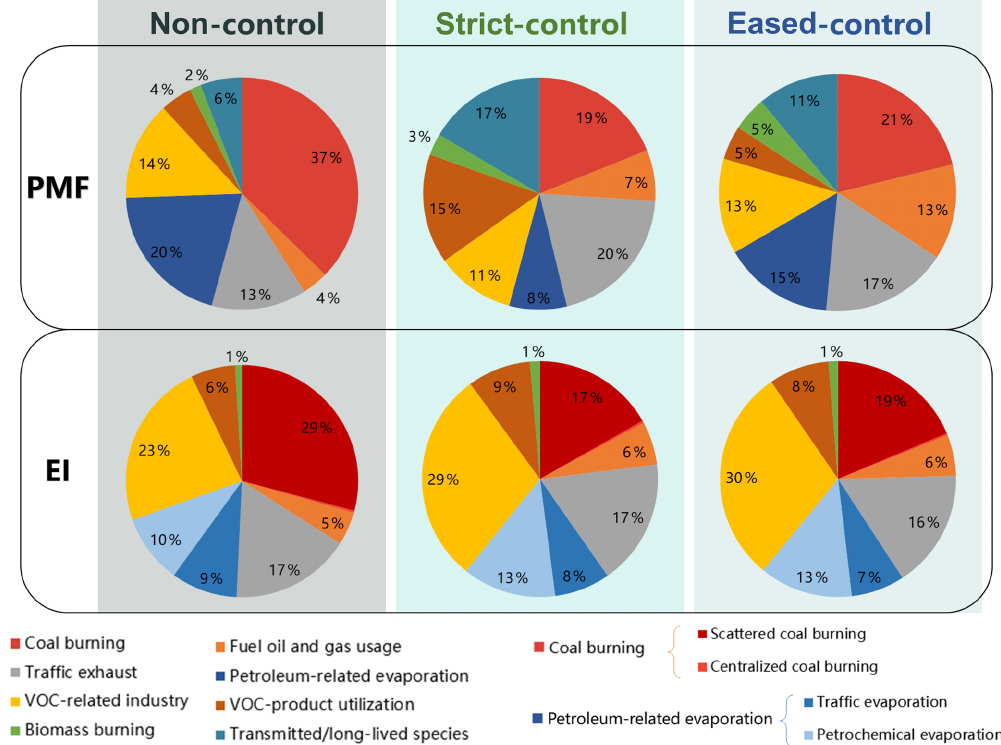
Figure 6. The comparison of the PMF result and the corrected emission inventory of different control periods.